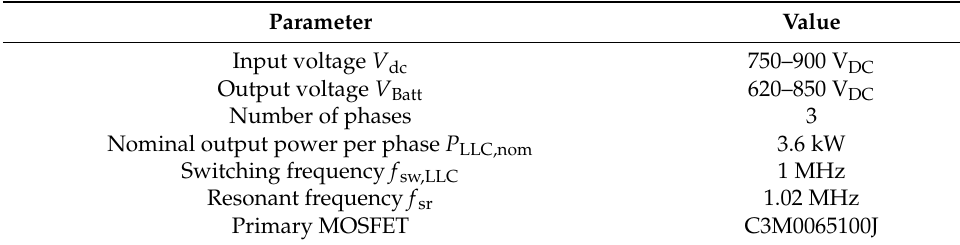
Table 6. Specification of the LLC resonant